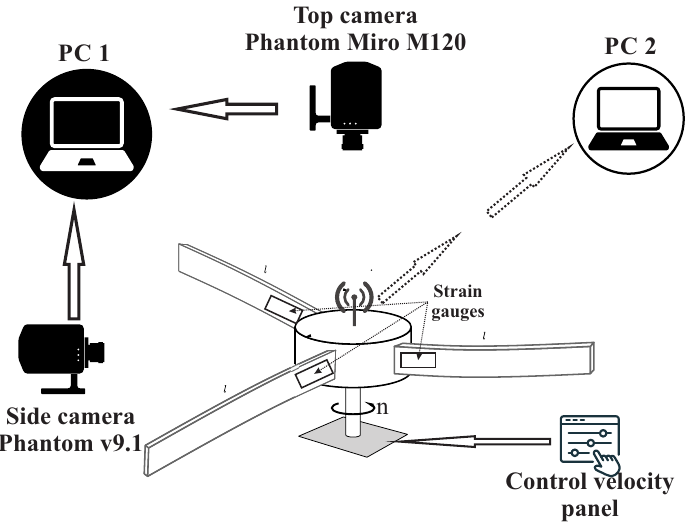
Figure 2. Diagram of the measuring